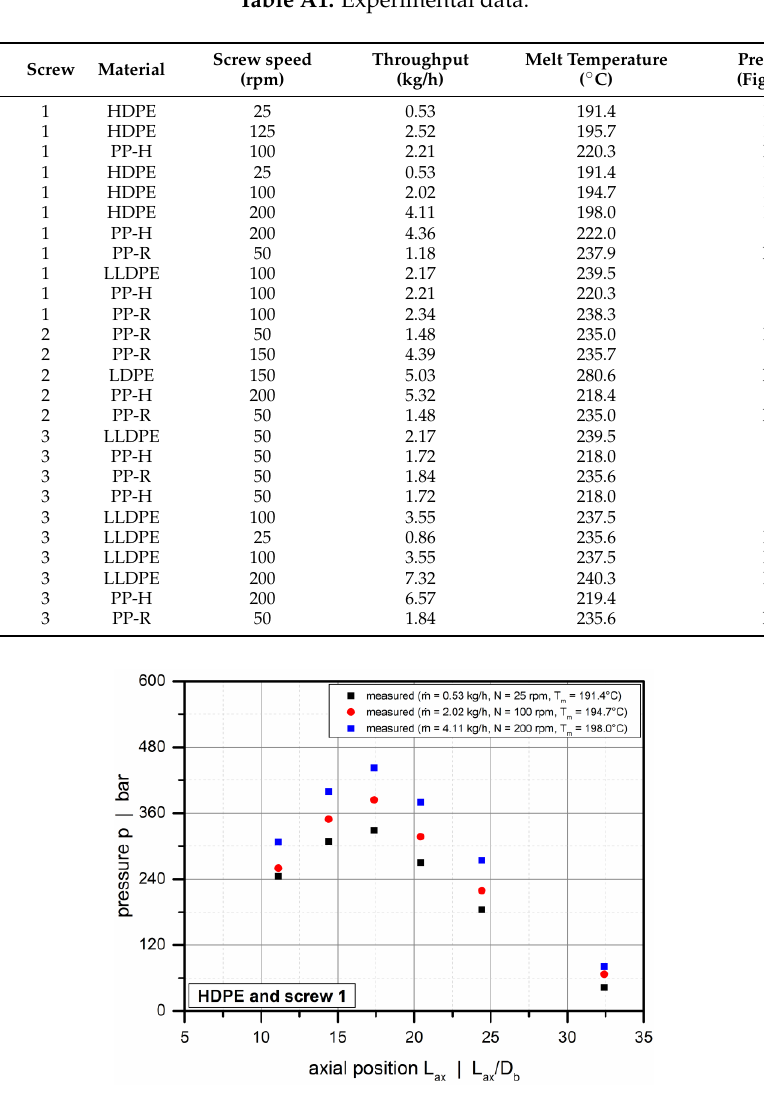
Figure A1. Experimental pressure profiles for HDPE and screw 1.